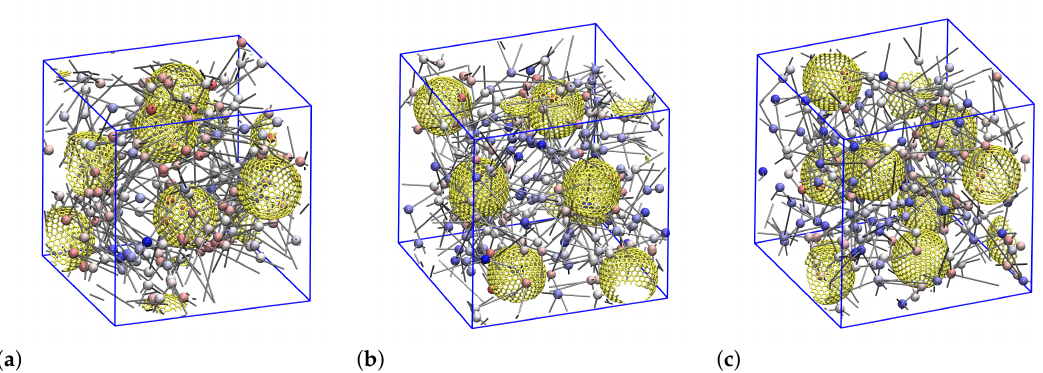
Figure 11. Entanglement network. 3D snapshots of entanglements (colorful spheres) residing on the multiple disconnected shortest path (gray cylinders) for dispersed p3-charged chains of ( a ) N = 40, ( b ) N = 100, and ( c ) N = 200 at an NP volume fraction of φ ≈ 11.6%. The entanglements (spheres) are colored based on their distance to their closest NP, from red (smallest distance) to blue (largest distance). The polymer chains are not shown here for the sake of clarity. 2D-view snapshots of these three entanglement networks are shown in Supplementary Figure